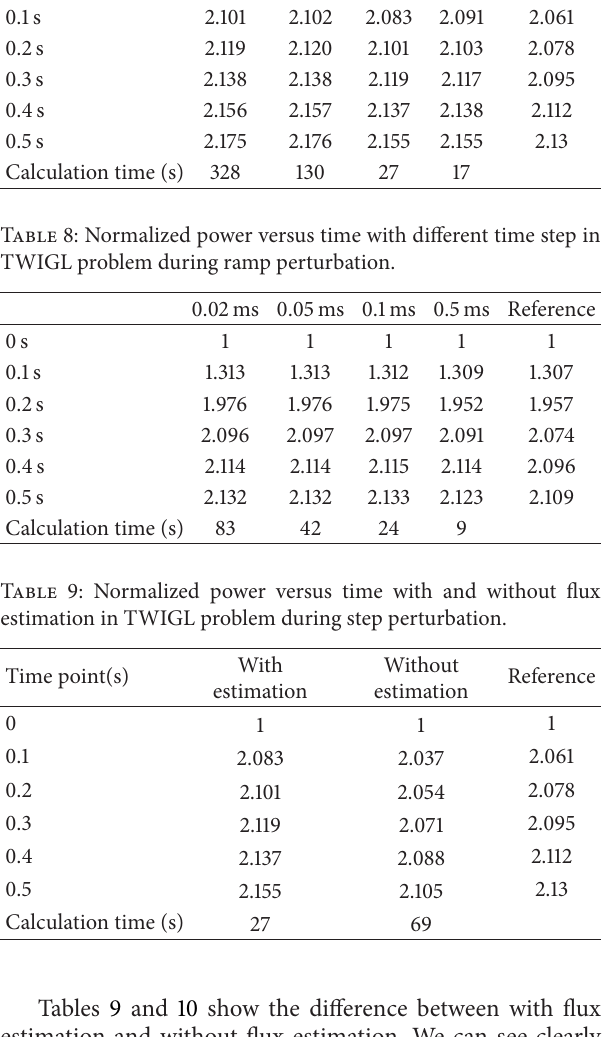
Table 11: Normalized power versus time with and without fission source extrapolation in TWIGL problem during step perturbation. With Without Time point (s) extrapolation